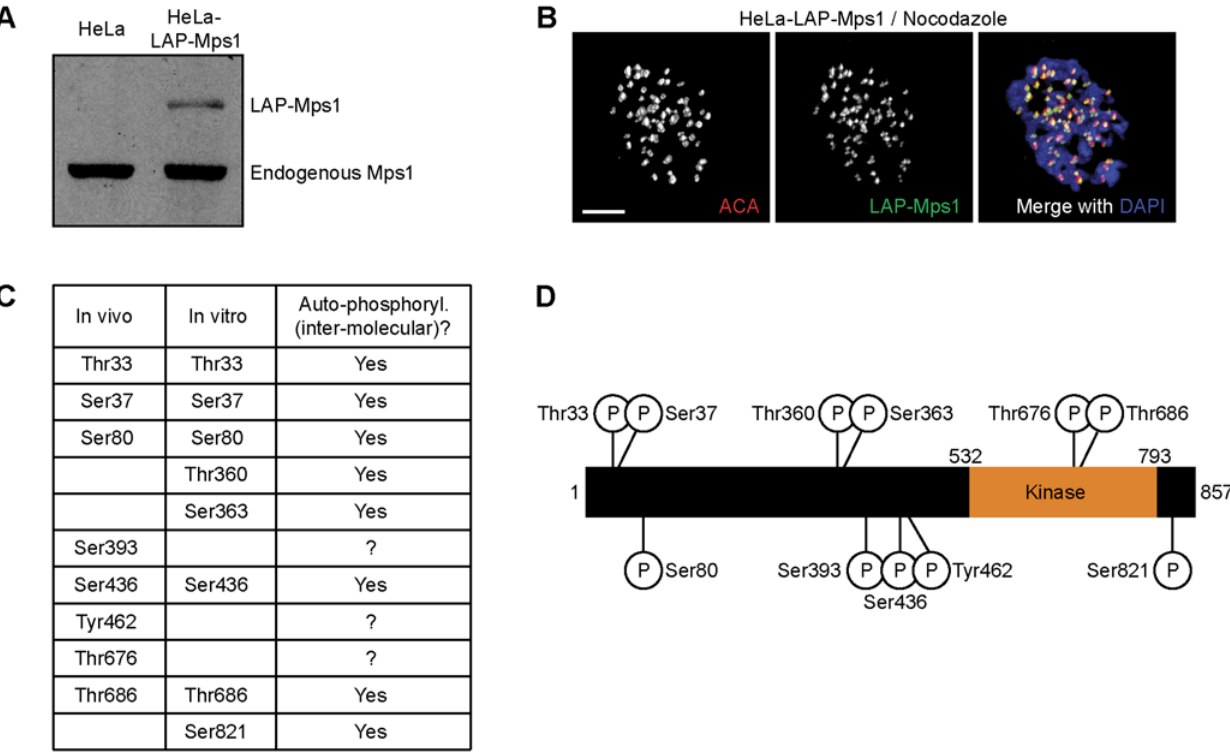
Figure 1. Mps1 is phoshorylated during mitosis on at least 7 residues. (A, B) A monoclononal Hela cell line stably expressing LAP-tagged Mps1 (HeLa-LAP-Mps1) was analyzed for expression level of LAP-Mps1 relative to endogenous Mps1 as shown by immunoblot (anti-Mps1) (A) and localization of LAP-Mps1 (anti-GFP) together with centromeres (ACA) and DNA (DAPI) (B). Scale bar is 5 m m. (C) List of phosphorylation sites identified by mass spectrometry on LAP-Mps1 isolated from mitotic HeLa-LAP-Mps1 cells (left column, in vivo) or on recombinant Mps1 isolated from insect cells (middle column, in vitro). Phosphorylation sites on recombinant Mps1 were designated ‘auto-phosphorylations’ when sites were not found on similarly expressed and isolated recombinant kinase-dead Mps1. (D) Schematic overview of phosphorylated residues on